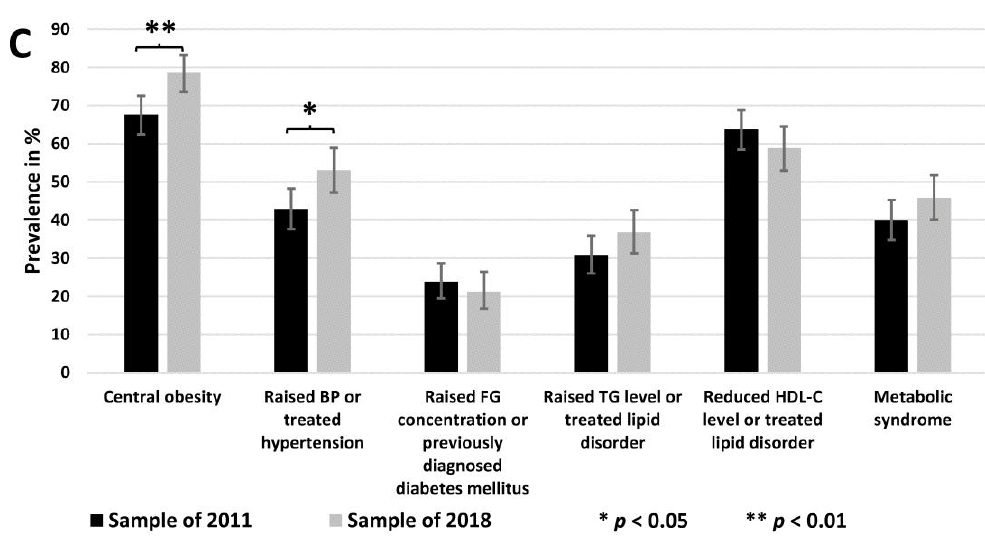
Figure 1. Prevalence of metabolic syndrome and its components among Roma of Northeast Hungary in 2011 and 2018 (( A ) in the populations studied, ( B ) in males, and ( C ) in females). BP: blood pressure; FG: fasting plasma glucose; TG: triglyceride; HDL-C: high-density lipoprotein cholesterol.